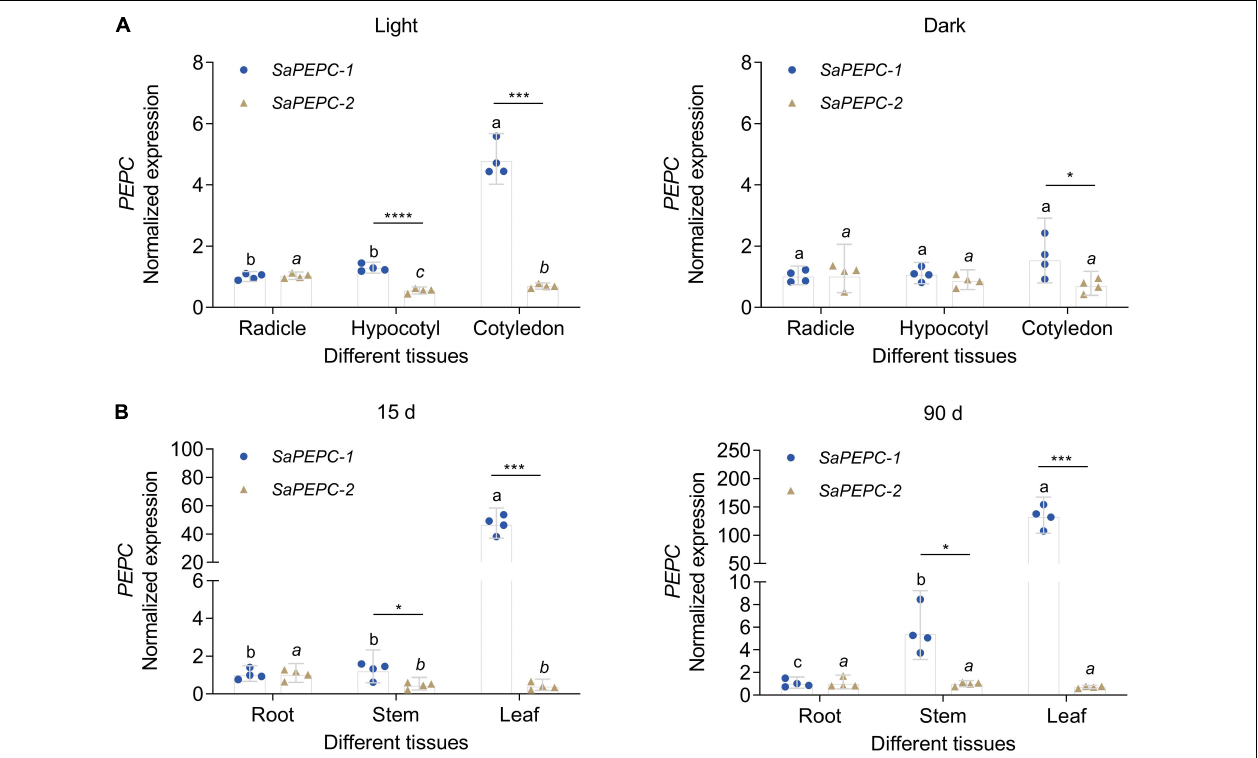
FIGURE 7 | Relative expression of two SaPEPC genes in different tissues of S. aralocaspica . (A) Light and darkness treatments in seed germination; (B) Different growth stages of seedlings. Different lowercase letters indicate significant differences of the same gene in different tissues; *, ***, ****: Indicate a significant difference between SaPEPC-1 and SaPEPC-2 in the same tissue at 0.05, 0.001, 0.0001 level, respectively. Values are geometric mean ± 95% CI of four biological